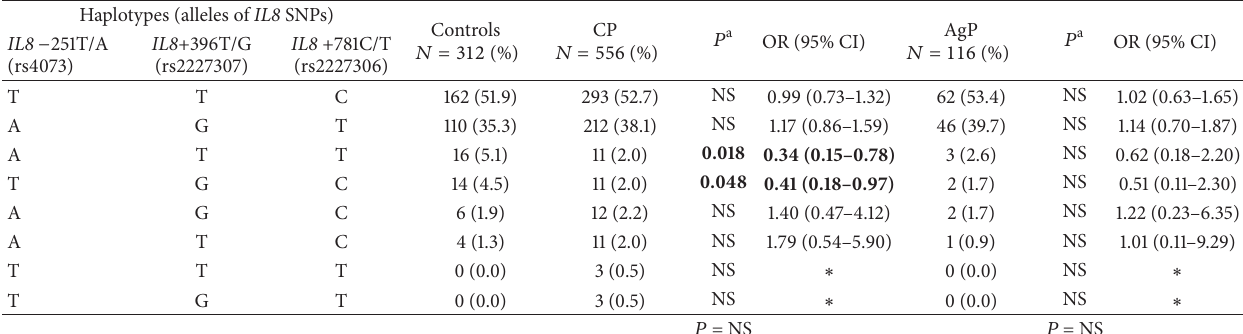
Table 3: Distribution of IL8 haplotypes in the studied groups.